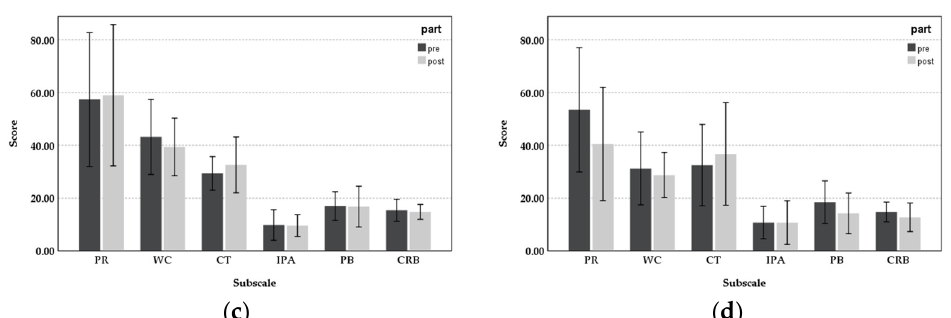
Figure 5. Subscale scores of NSC and CBI pre-post intervention: ( a ) General department; ( b ) Palliative care department; ( c ) ObGyn department; and ( d ) ICU (** p < 0.01).